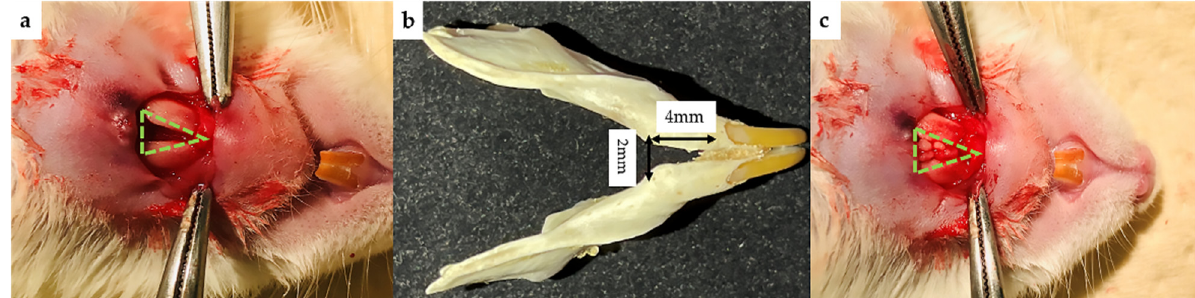
Figure 13. Rat congenital cleft-jaw model. ( a ) Mandibular defect before surgery. ( b ) Size of the mandibular defect model (width 2 mm, height 4 mm, depth 1 mm). ( c ) CellSaic placed into the defect model.